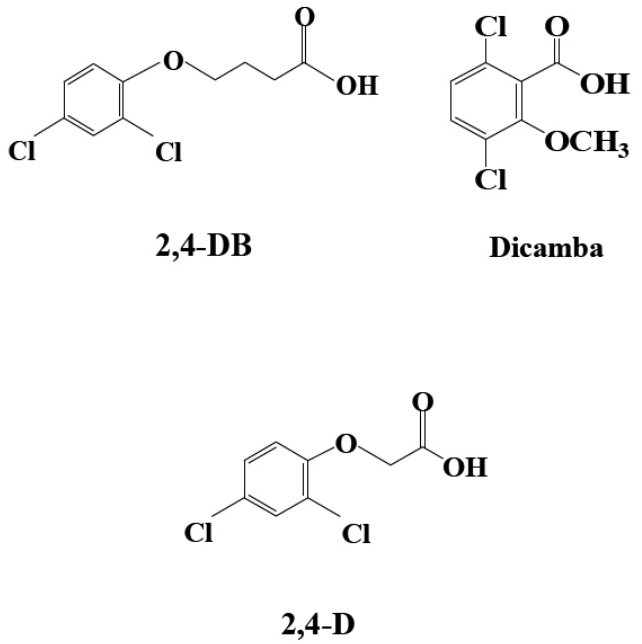
Figure 1. Molecular structures of the PAs analyzed in this